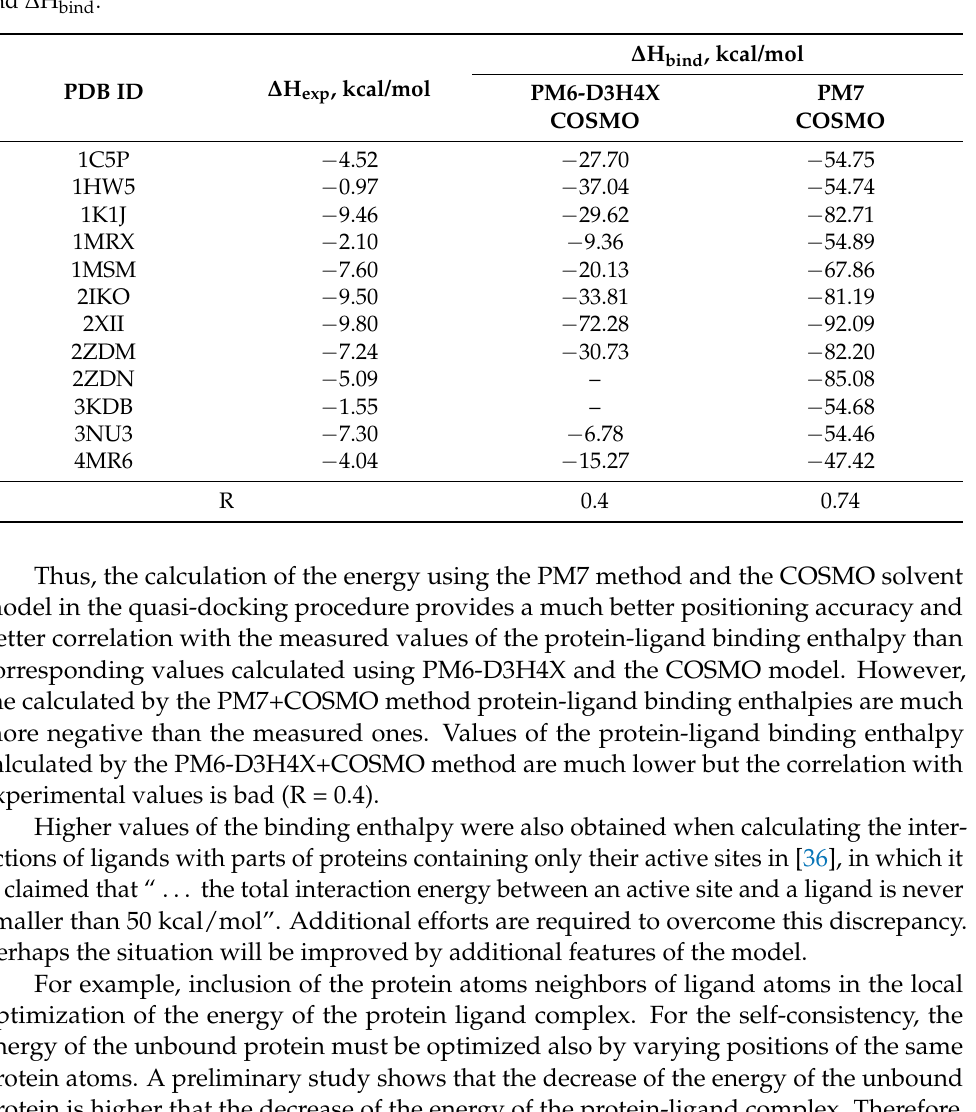
Table 3. The experimentally measured ∆ H exp and calculated ∆ H bind binding enthalpies; PDB ID is the identifier of the complex in Protein Data Bank; R is the correlation coefficient between ∆ H exp and ∆ H bind